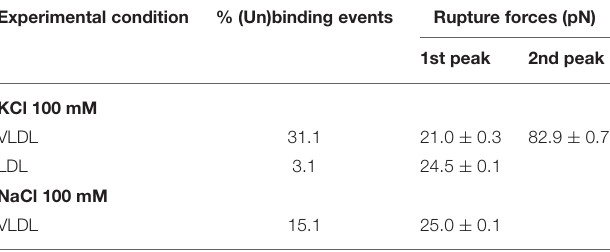
TABLE 3 | Rupture forces and percentage of (un)binding events determined with AFM-based force spectroscopy for the interaction between WNV C and VLDL or